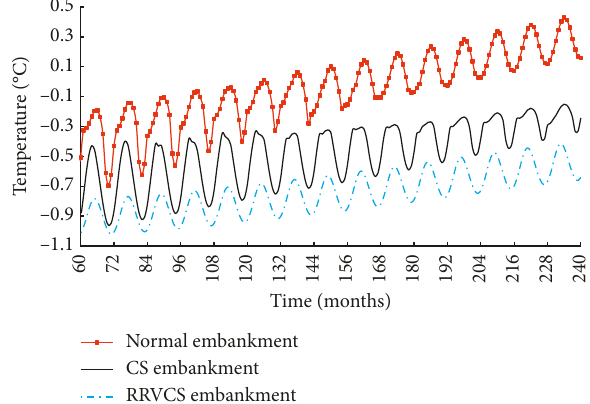
Figure 10: Temperature variations with service time for different